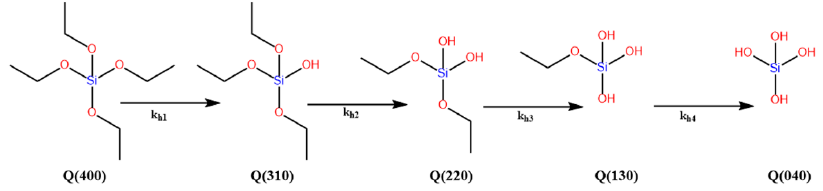
Figure 3. The hydrolysis of TEOS.